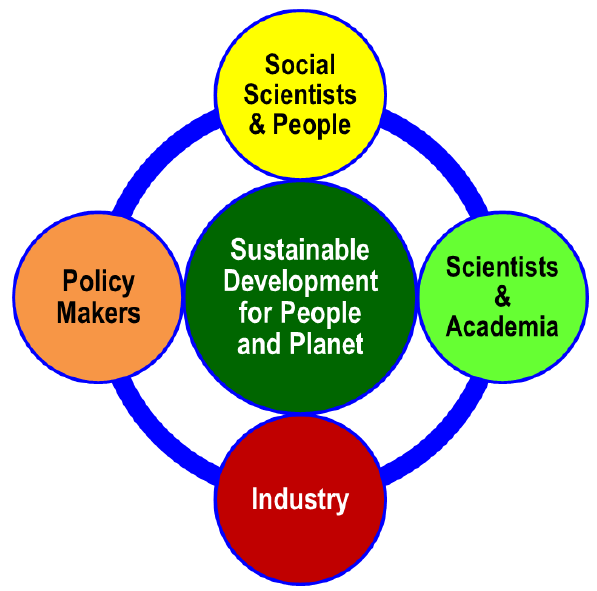
Figure 1. Stakeholders of global sustainability. All stakeholders should play their roles for sustainable global development.